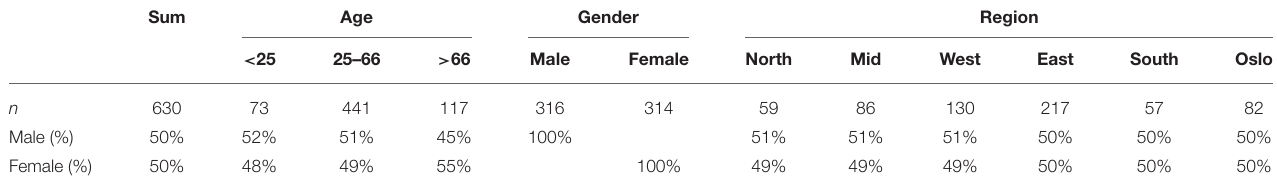
TABLE A1 | Survey respondents’ age, gender, and geography.